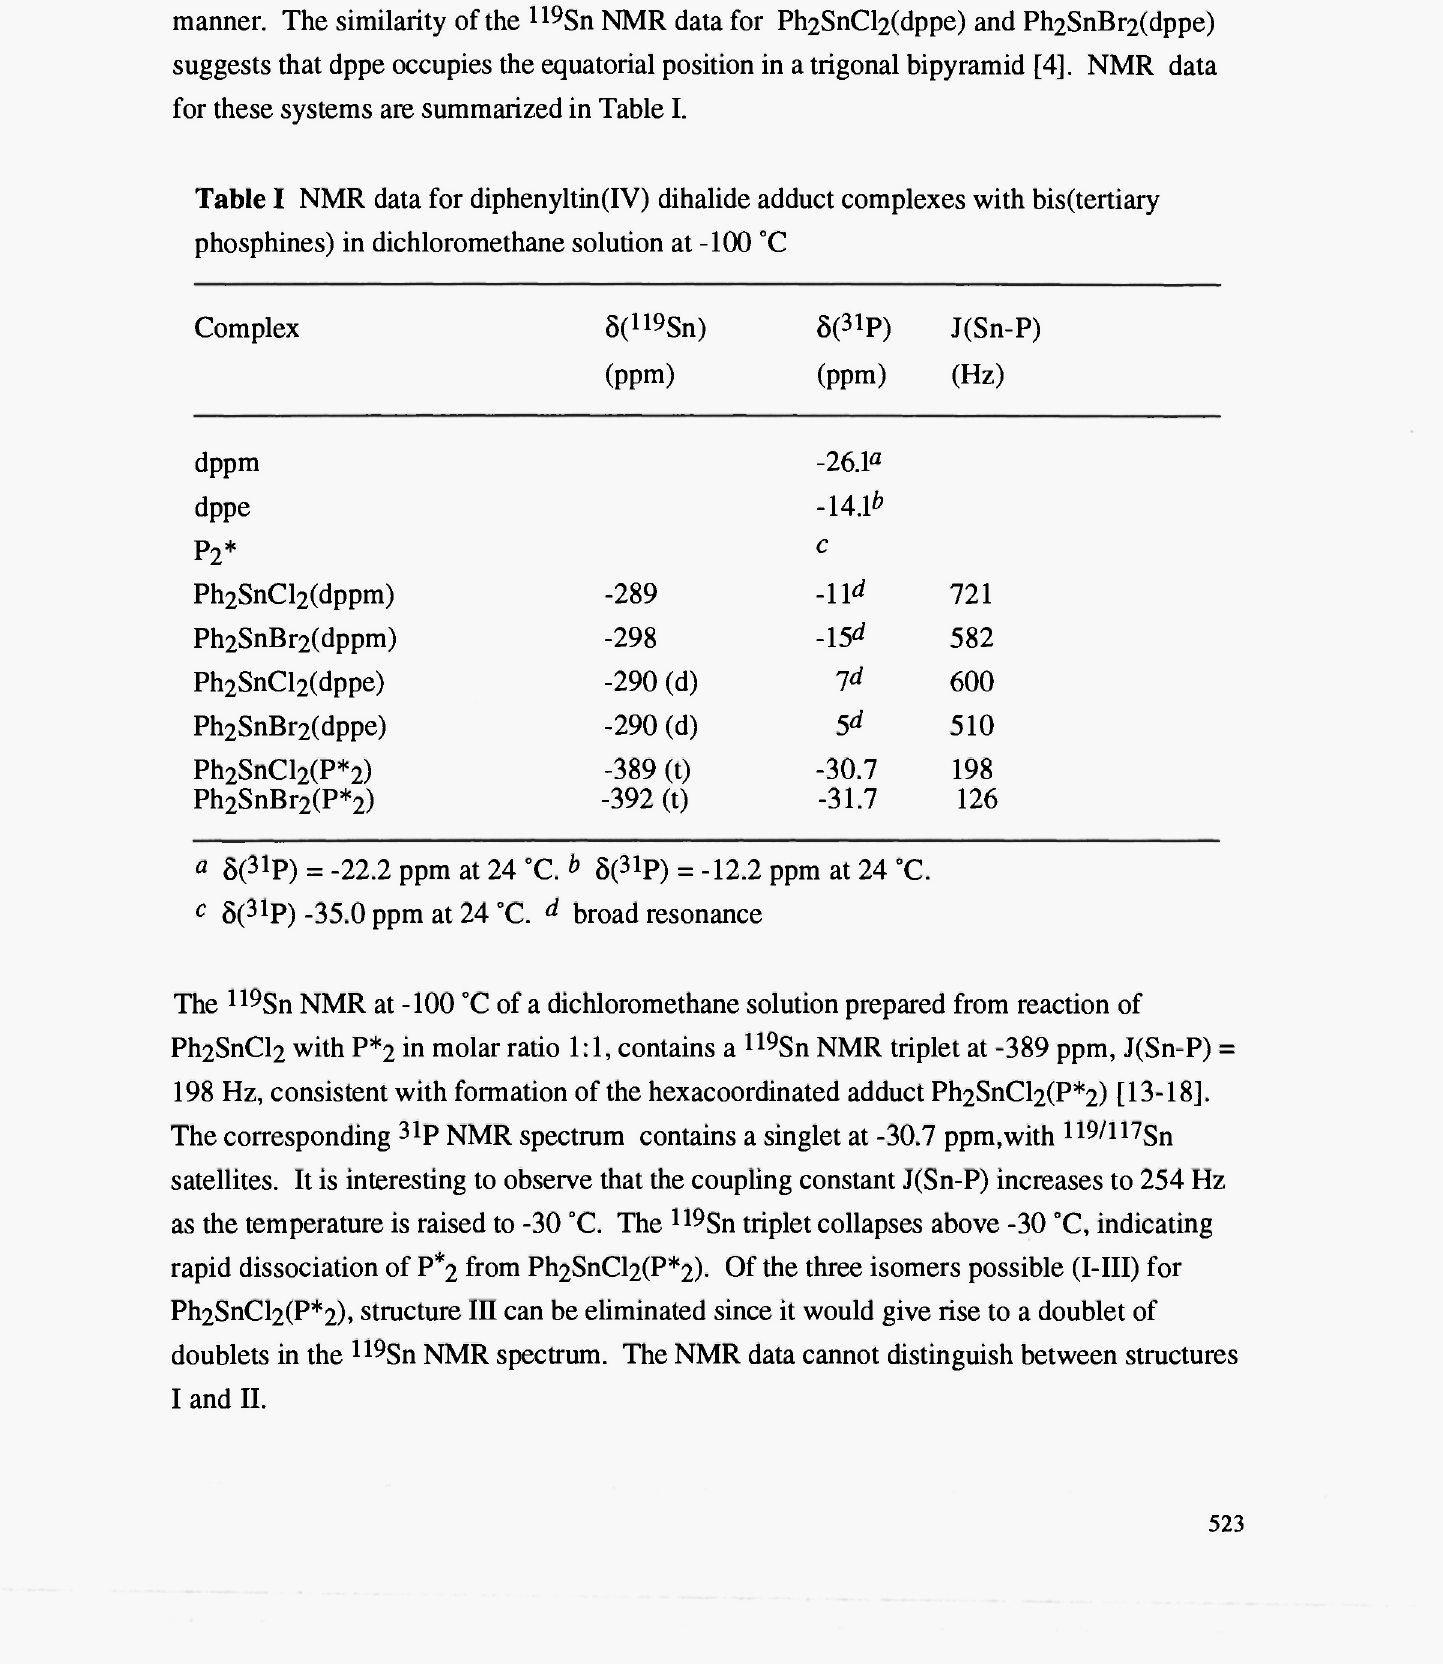
Table I NMR data for diphenyltin(IV) dihalide adduct complexes with bis(tertiary phosphines) in dichloromethane solution at -100 °C